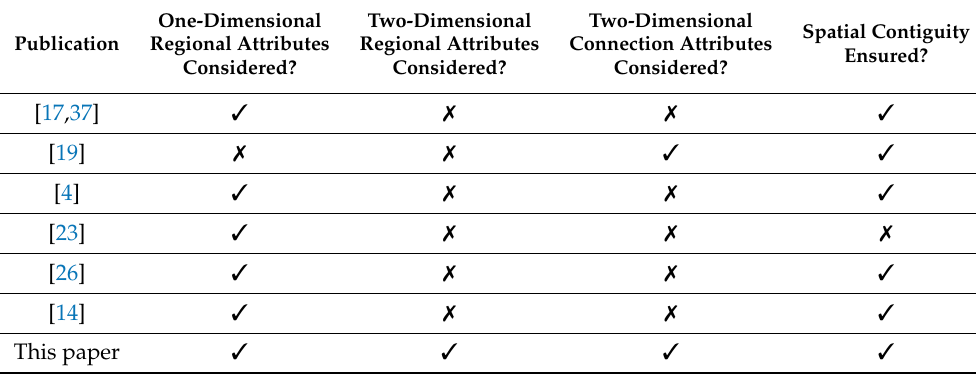
Table 3. Comparison of the spatial aggregation approach proposed in this paper with the previous